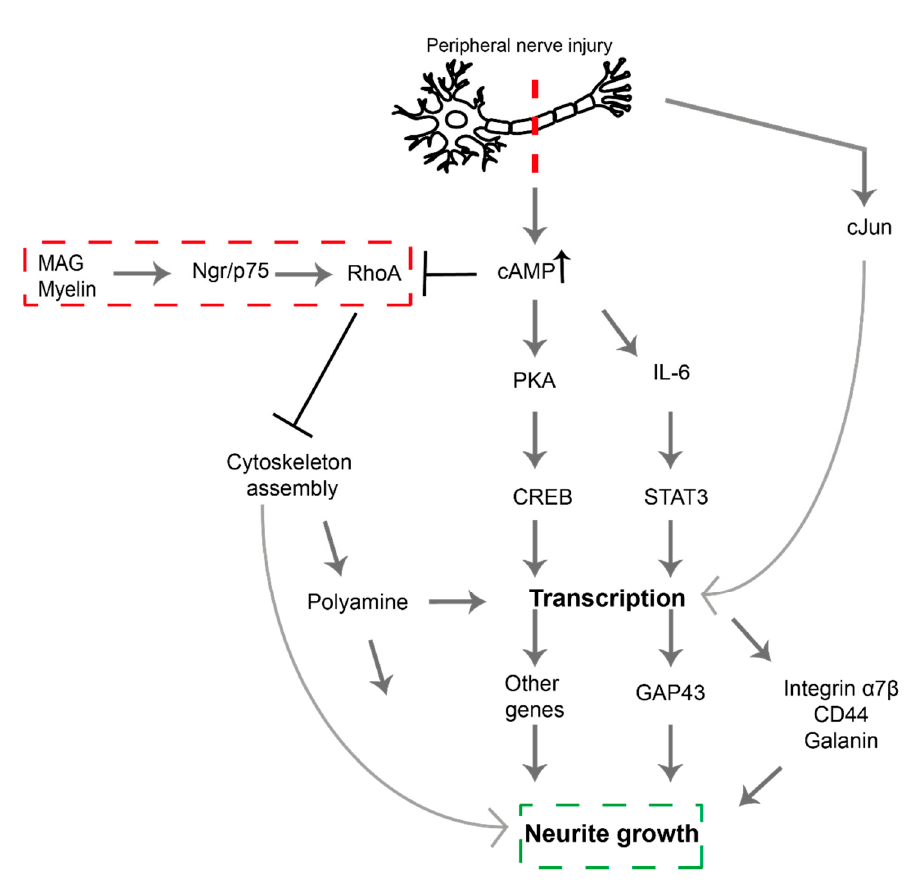
Figure 1. Signaling pathways following peripheral nerve injury. All pathways are excitatory acting to enhance axonal growth except the Rho/ROCK inhibitory pathway indicated in red. Modified from [12] . Myelin-associated glycoprotein (MAG), Nogo receptor (Ngr), p75 neurotropic receptor (p75 NTR ), Ras homolog family member A (RhoA), Cyclic Adenosine Monophosphate (cAMP), Protein kinase A (PKA), cAMP-response Element-Binding Protein (CREB), Interleukin-6 (IL-6), Signal Transducer and Activator of Transcription 3 (STAT3) [19] .